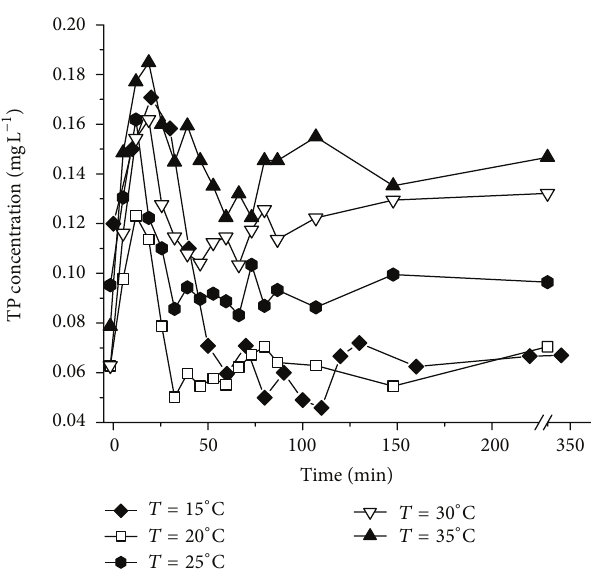
Figure 3: Concentration changes of TP in the temperature effect experiments.